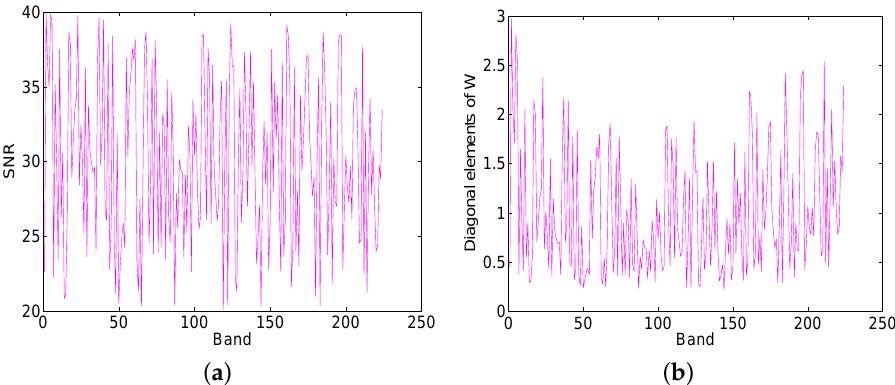
Figure 5. ( a ) The signal-to-noise ratio (SNR) of different band of the generated hyperspectral image (HSI) and ( b ) diagonal elements of the weighting matrix using proposed sparse unmixing method based on noise level estimation (SU-NLE) in simulated experiment I.